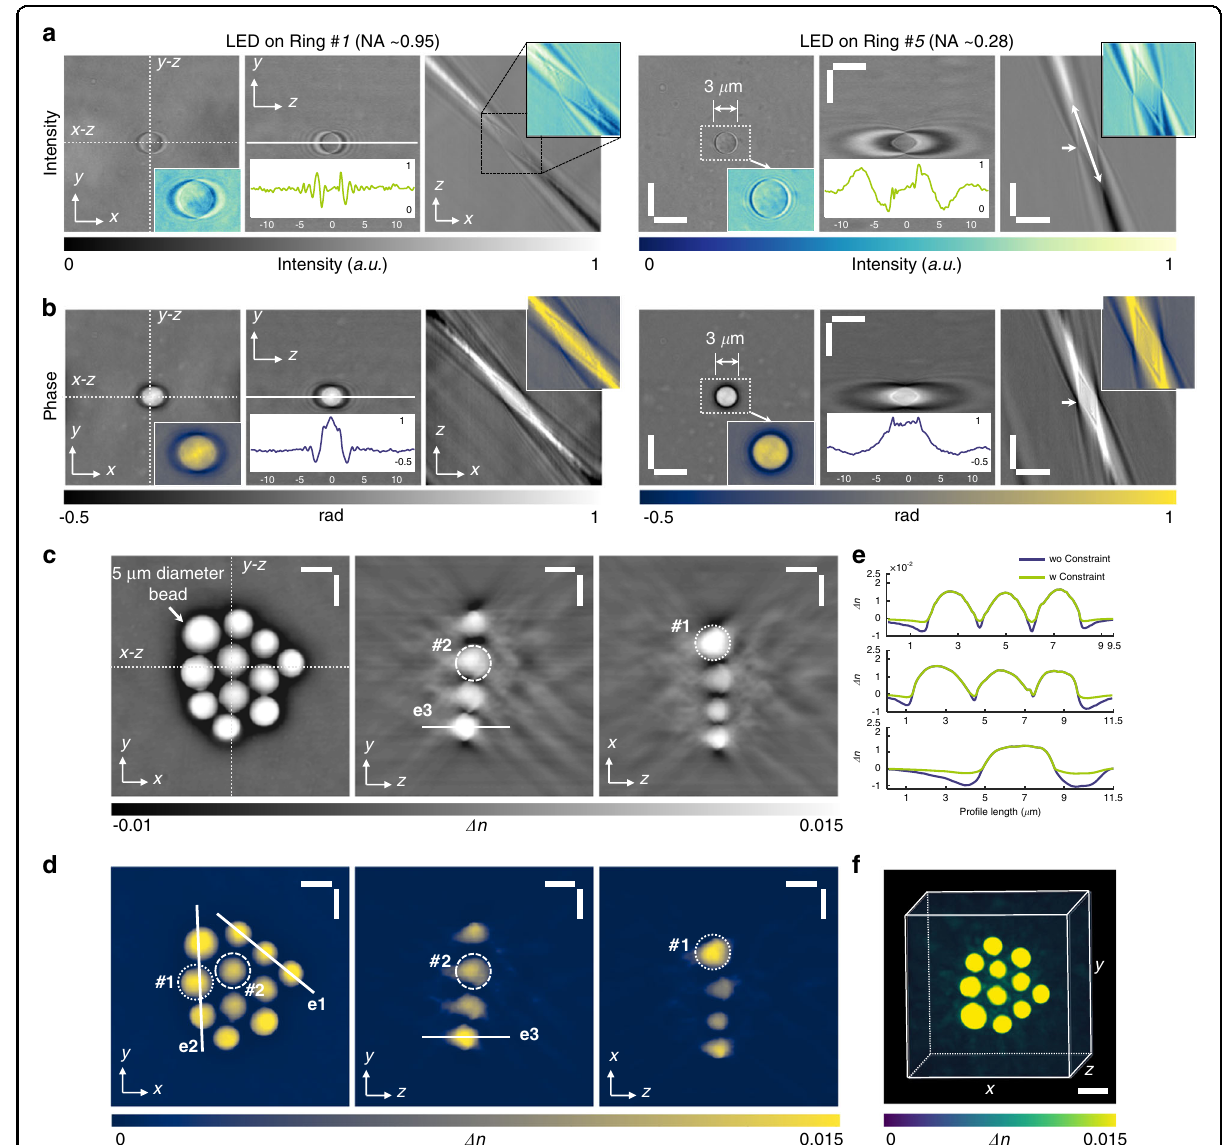
Fig. 3 Experiments of 3D quantitative tomographic RI of polystyrene beads with different sizes. a , b Distributions of measured intensity stacks and retrieved phase stacks of micro polystyrene sphere with 3 µm diameter by implementing imaginary part recovery via intensity Kramers-Kronig relations under two different illumination angles. c – e RI tomograms of a cluster of polystyrene beads wo/w iterative constraint are reconstructed after the synthesis of the recovered 3D phase information under each illumination angle in the x − y , x − z , and y − z planes. f Rendered RI distribution as a 3D volume of bead cluster structure. Scale bars: 5